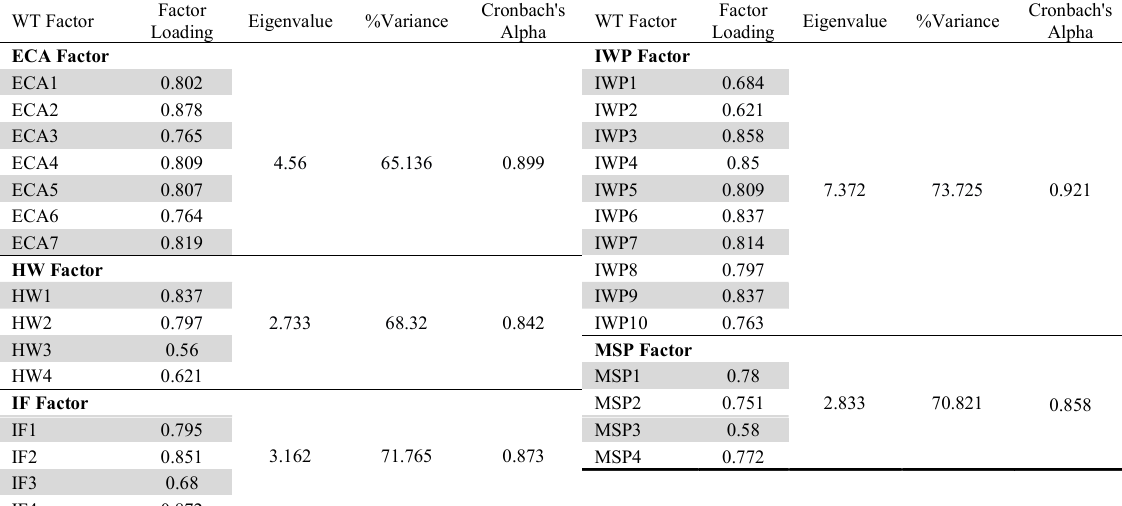
Internal Consistency and Factor Loading Tests for WT